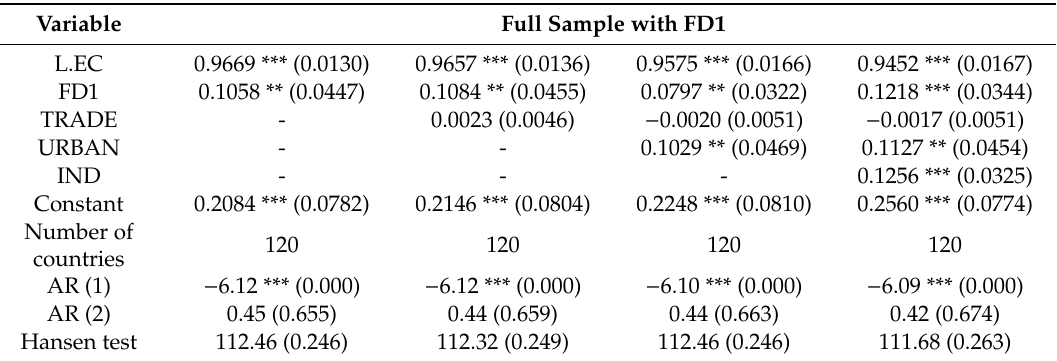
Table 6. Results of the full sample regressions with